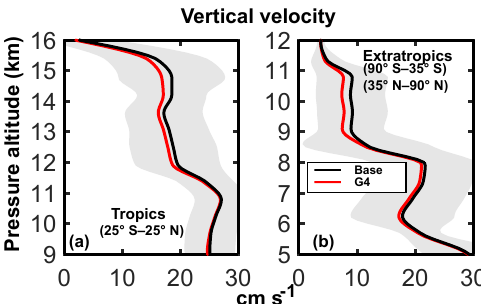
Figure 8. Average upper tropospheric profiles of the vertical veloc- ity (cms − 1 ) in the G4 and Base experiments (years 2030–2069). Panels (a) and (b) are for the tropics and extratropics, respectively (see legends). The vertical velocity w is obtained as the sum of the large-scale value and that calculated as a function of the TKE (see Lohmann and Karcher, 2002 and Eq. 5), which essentially accounts for the synoptic scale and gravity wave motions. The shaded areas of the same color represent ± 1 σ for the ensemble over the 40-year period from 2030 to